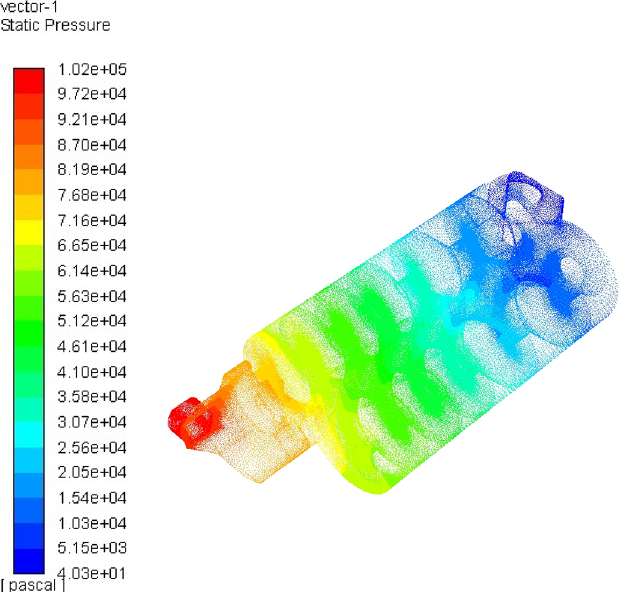
Fig. 11. Pressure distribution diagram of the fl uid domain.